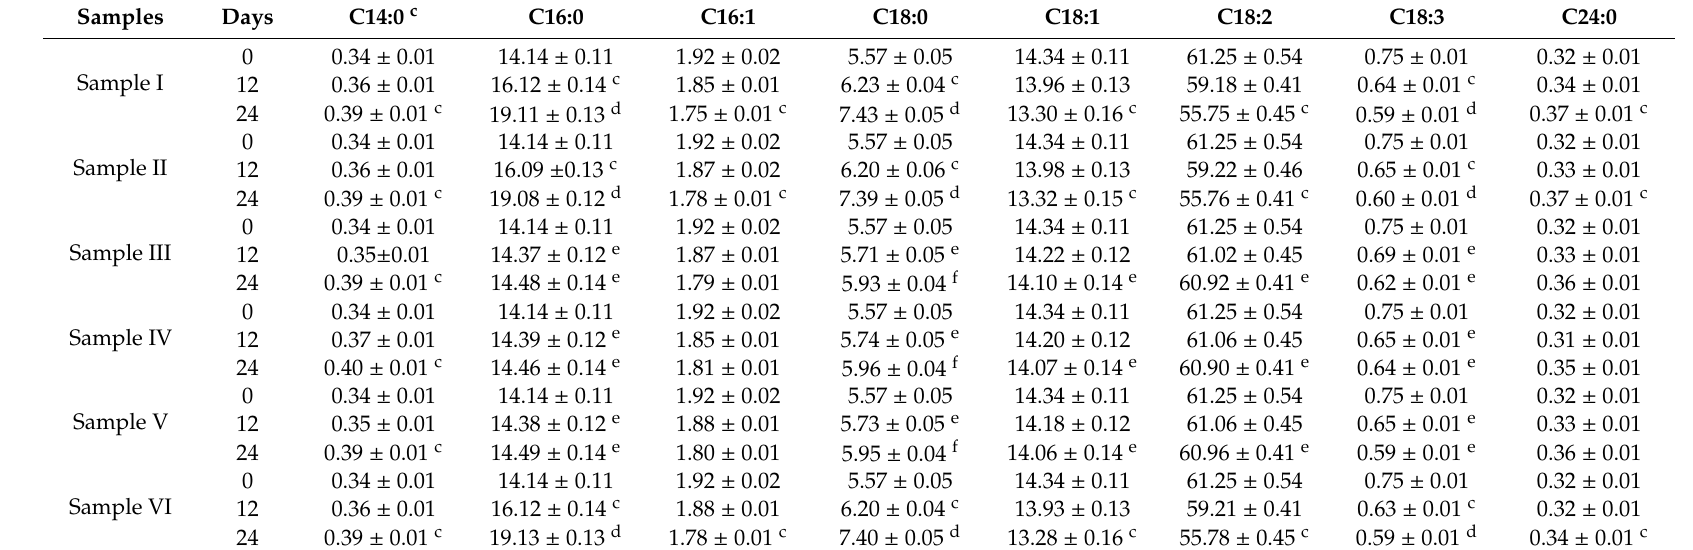
Table 2. Fatty acid composition of sunflower oil samples at 65 ◦ C for 24 days influenced by ADEO a